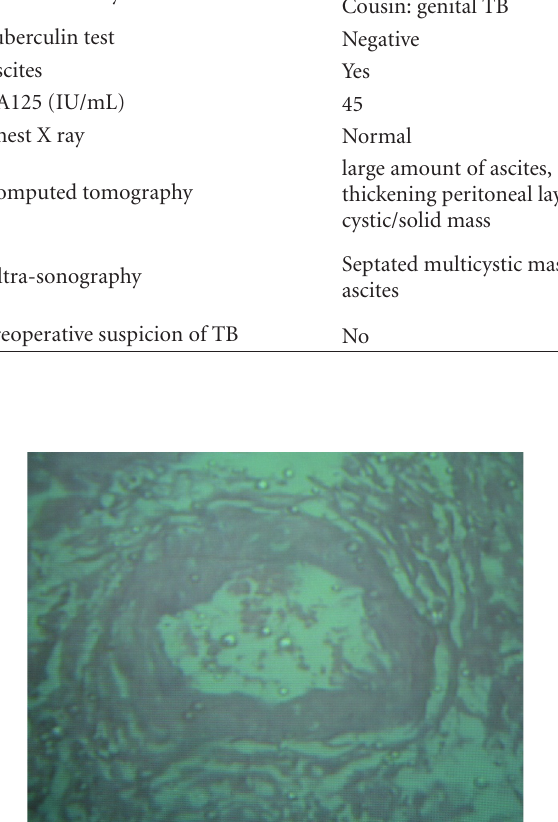
Figure 1: Microscopic picture showing chronic granulomatous inflammation with epitheloid histiocytes and Langhans type multi- nucleated giant cells (Case